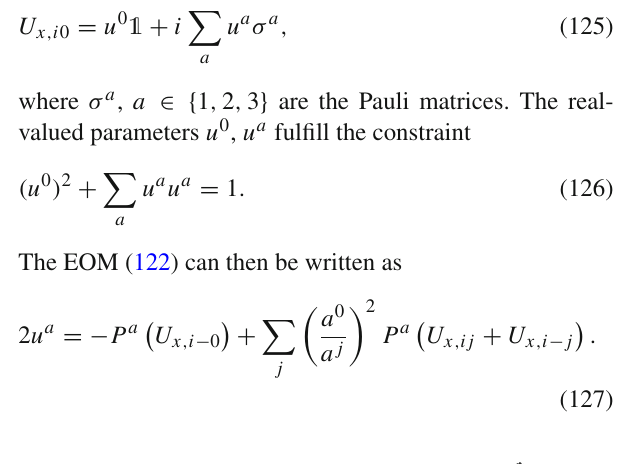
Fig. 2 Left: the Wilson line associated with the plaquette U x , ij . Right: the Wilson lines associated with the lattice field strength C x , ij . Spatial linkvariablesaredrawnassolidblackarrows. Whiletheplaquettestarts